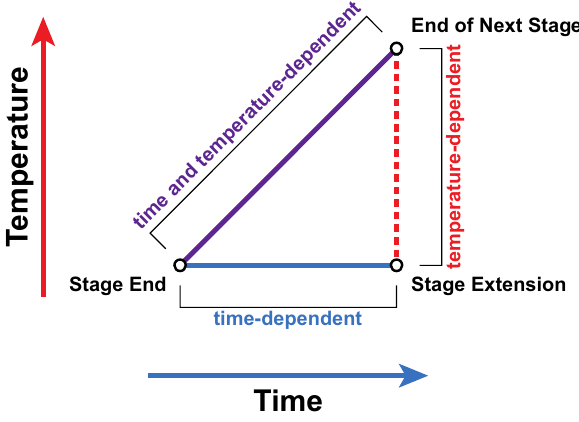
Figure 4. Mash stage extension allows differentiation between time- and temperature-dependent changes in protein abundance. Statistical comparison in protein or peptide abundance between the end of a stage, extension of the stage, and end of the next stage allows the determination of the cause of changes in abundance. A significant difference between ‘stage end’ and ‘stage extension’ corresponds to a time-dependent change in protein abundance. A significant difference between ‘end of next stage’ and ‘stage extension’ corresponds to a temperature-dependent change in protein abundance. A significant difference between only ‘stage end’ and ‘end of next stage’ corresponds to a time- and temperature-dependent change in protein